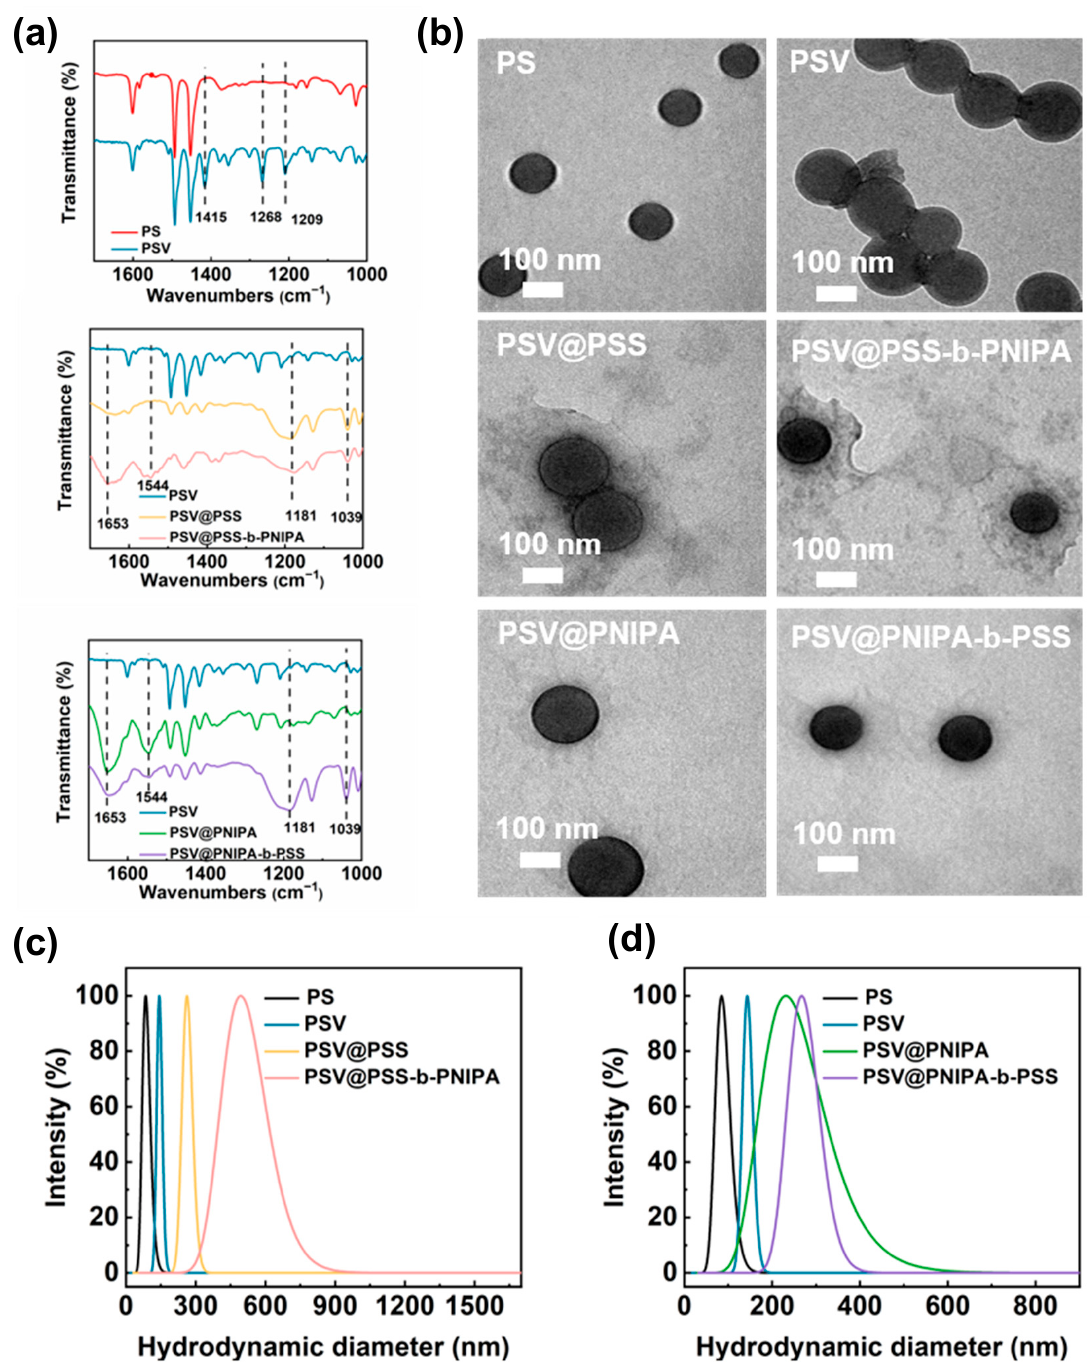
Figure 2. ( a ) FT-IR spectra and ( b ) TEM images and ( c , d ) size distribution of PS, PSV, PSV@PSS,